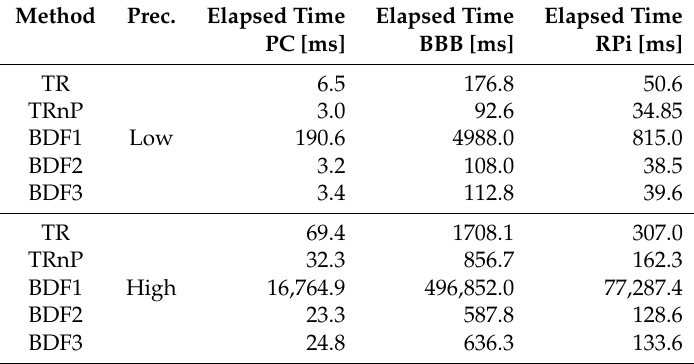
Table 9. Elapsed times in the simulation of the RLC